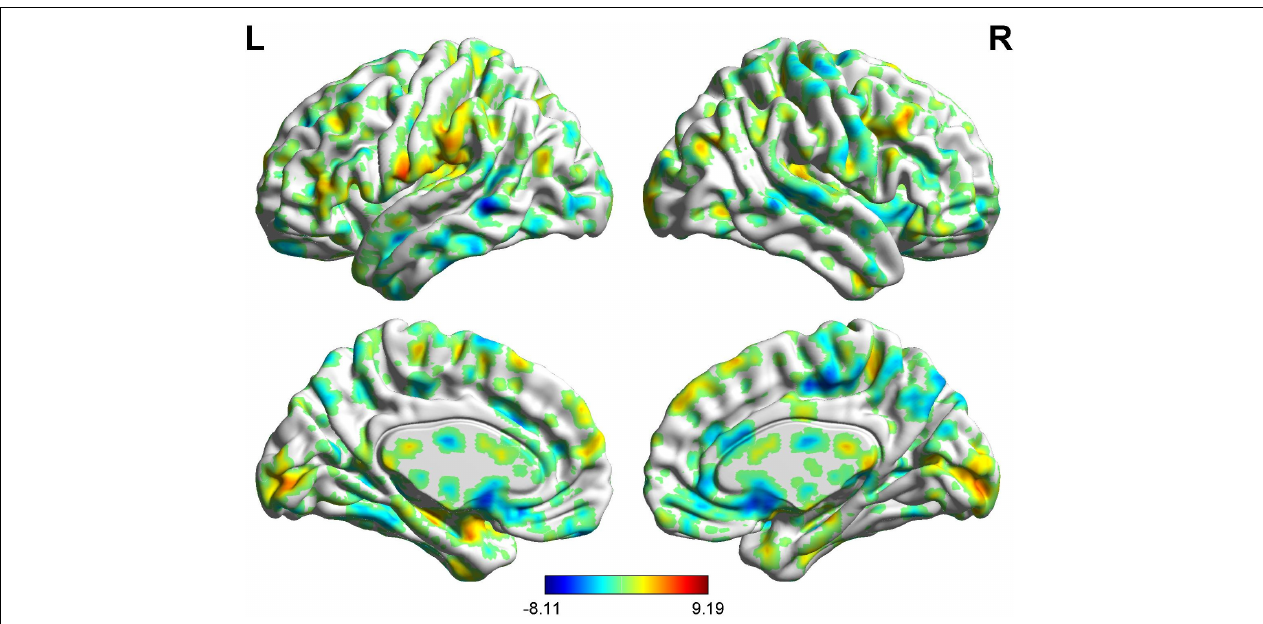
FIGURE 6 | Brain areas indicating functional connectivity with the rACC in placebo response in female participants. Color scale represents the Z -score. Red = placebo > pain; blue = pain > placebo.